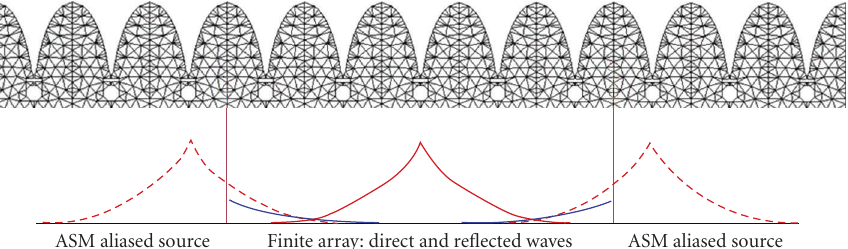
ASM aliased source Finite array: direct and reflected waves Figure 5: Wave phenomenology for port currents in finite and infinite arrays with a single excited element. Repeated curves are due to aliasing caused by numerical ASM